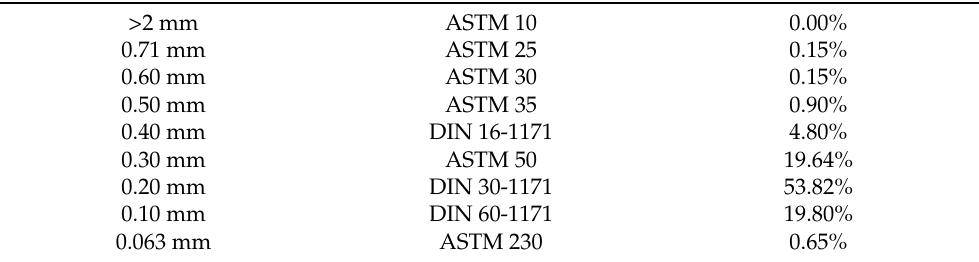
Table 7. Particle size of the sand grains, fractions 0.063 to 2 mm.